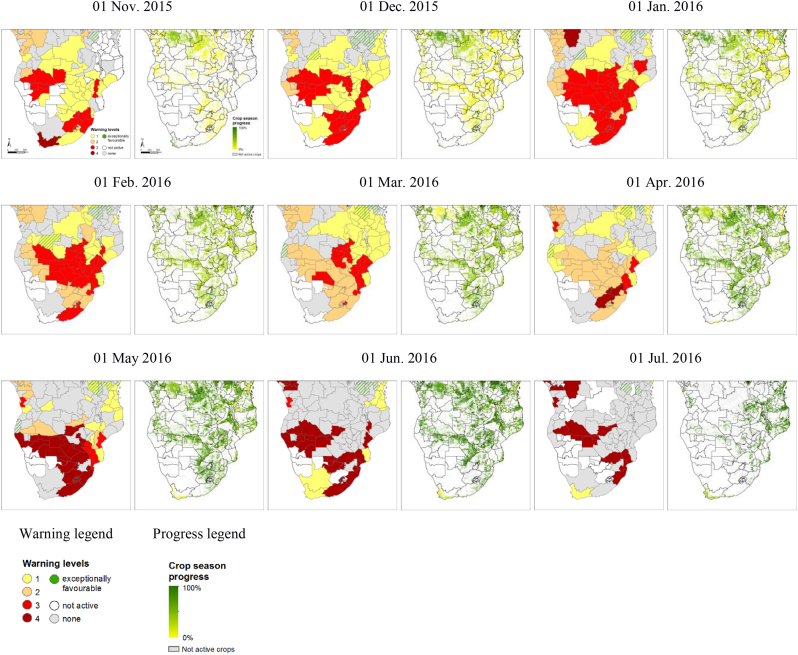
Temporal evolution of triggered warnings and progress of the season for the cropland areas in Southern Africa from November 2015 to July 2016. For each date the left and right panels represent the ASAP unit level warnings, and the pixel-level progress of the season, respectively. The reference date represents the first day of the 10-day period. Warning and progress legend are reported in the last row.